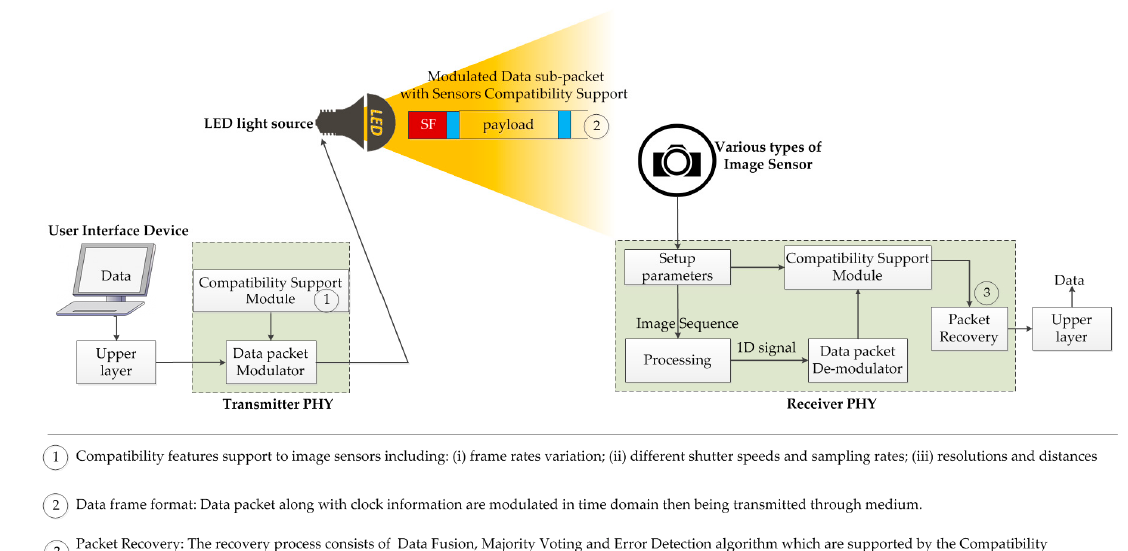
Figure 1. System architecture for compatible encoding scheme in time domain.